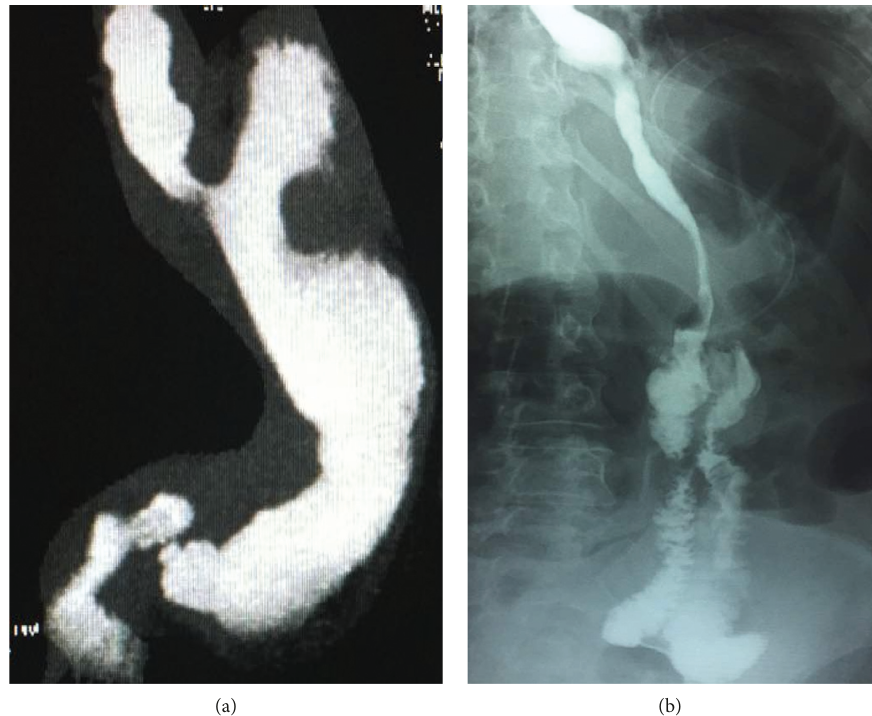
Figure 2: (a) Gastric prolapse following gastric plication; (b) postoperative X-ray swallow examination showing sleeve gastrectomy with omega loop